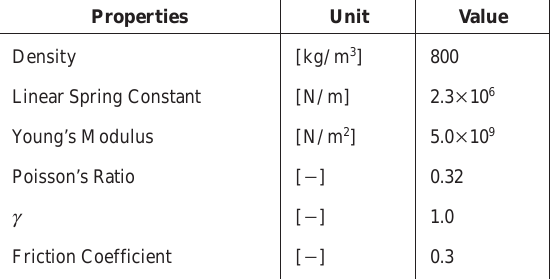
Table 1 Parameter settings for DEM simulation of ice